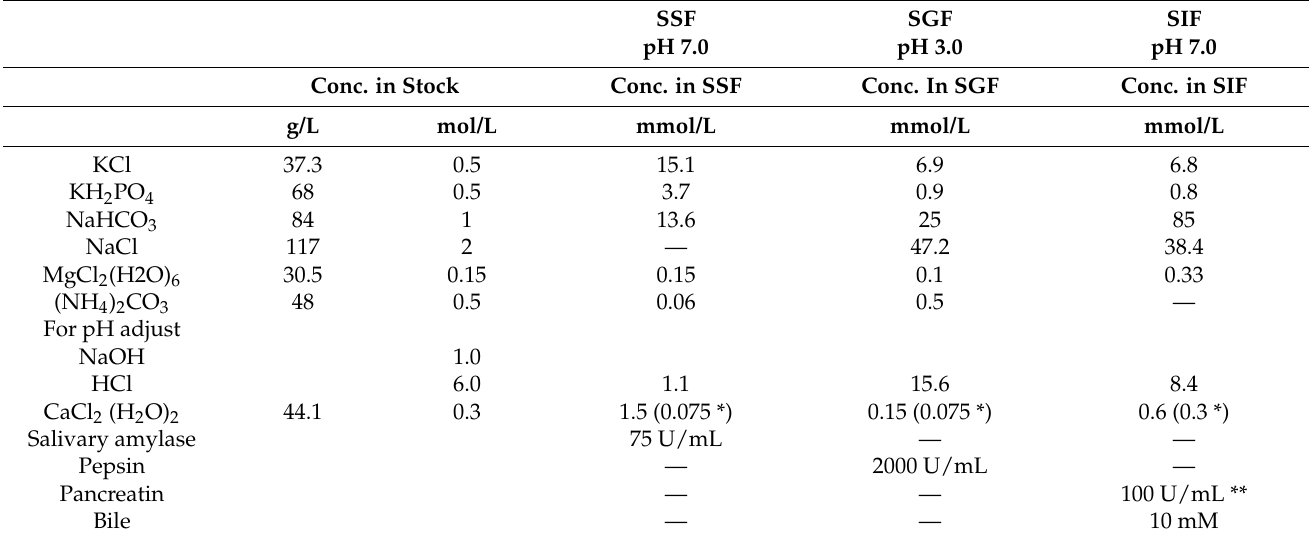
Table 1. Composition of simulated digestive fluids used for the in vitro